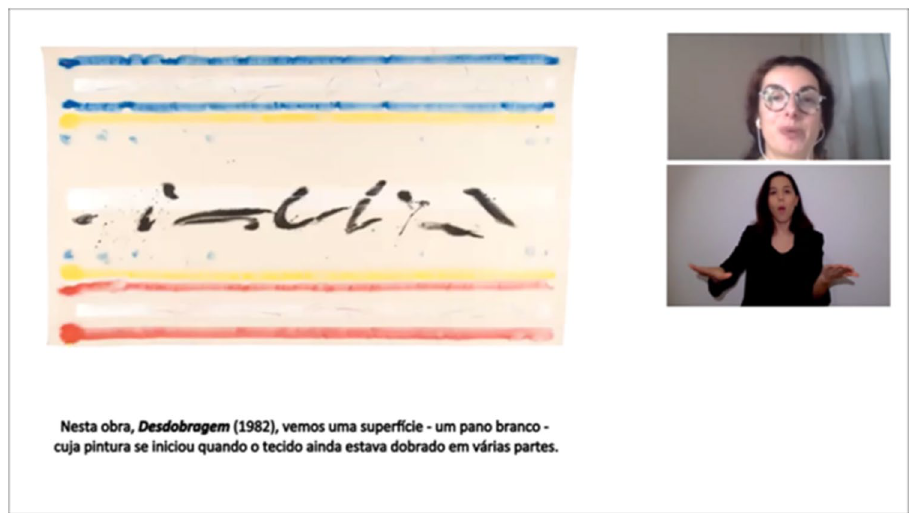
Figure 2. Still frame of the online class presentation designed to mimic a typical online presentation with visual to the left, written information in the bottom and presenter and PSL translator squares to the